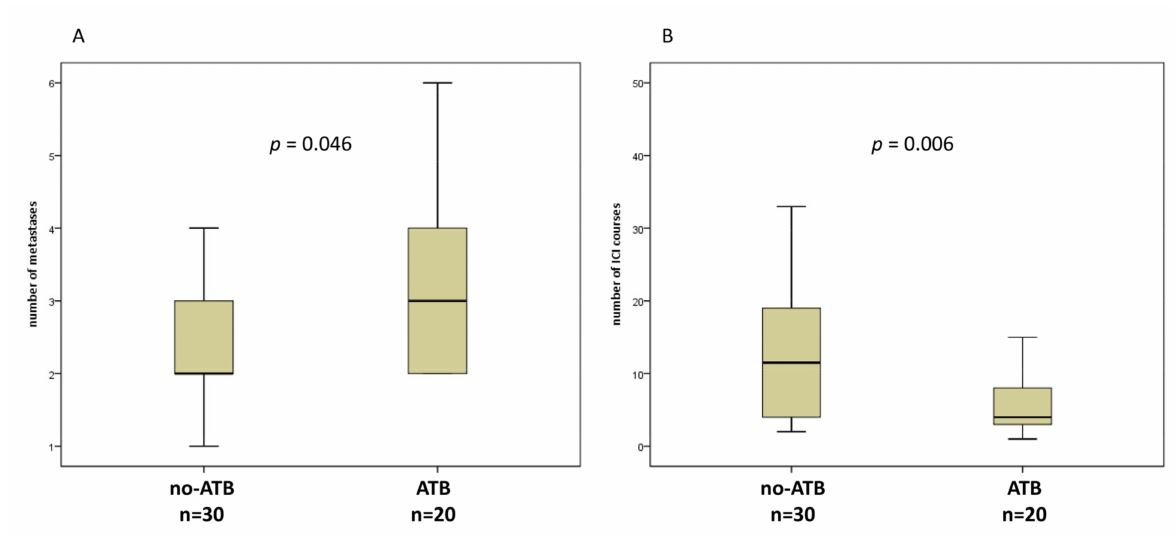
Figure 1. Box plots for number of metastases ( A ) and number of immune checkpoint inhibitors (ICI) courses ( B ) in patients without or with antibiotics (ATB) 1 month before and/or 1 month after the first dose of